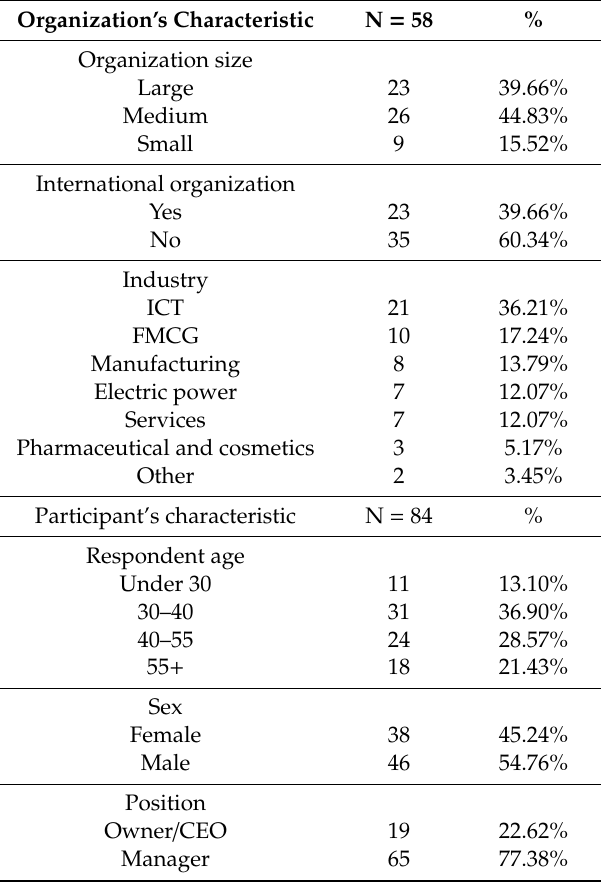
Table 2. Description of research